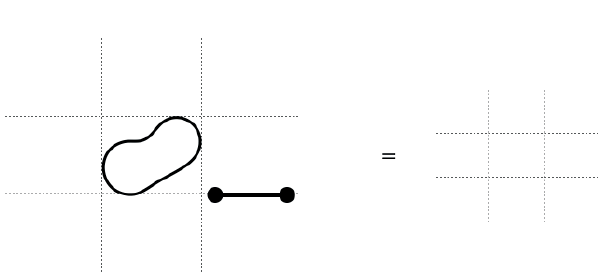
Figure 4: Application of the direction relation matrix to the relation between a line and a region. In this case, the line does not qualitatively intersect any of the tiles, therefore each tile is registered as empty, thus hiding the position of the